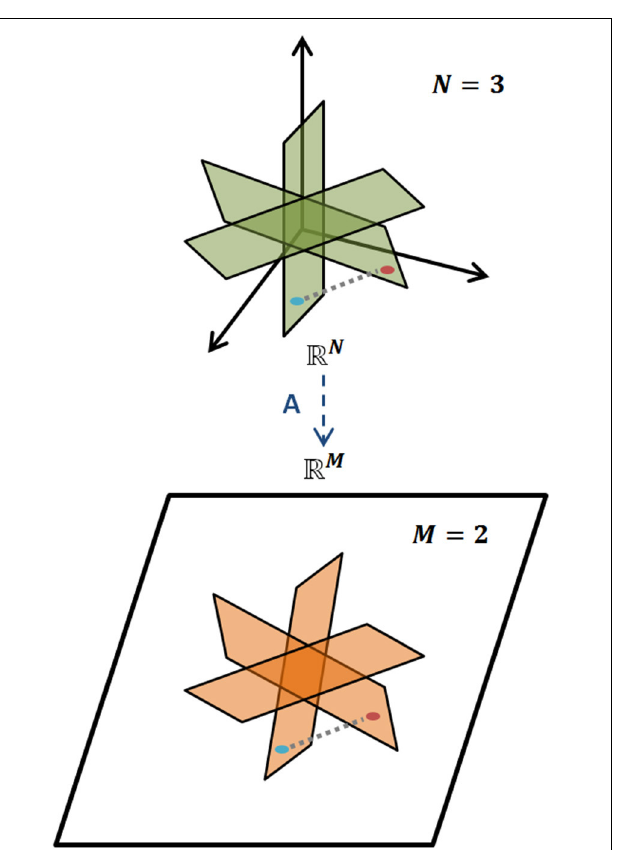
FIGURE 3 | Restricted Isometry Property. Illustration of RIP for a K -sparse model of signals, where geometric information is preserved when mapped, via A , from the N -dimensional space to the M -dimensional one, M < N